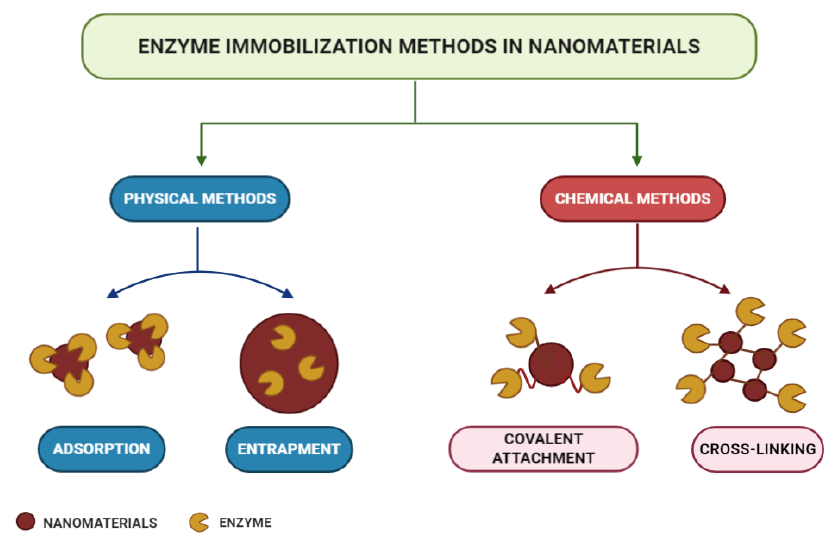
Figure 5. Enzyme immobilization methods.